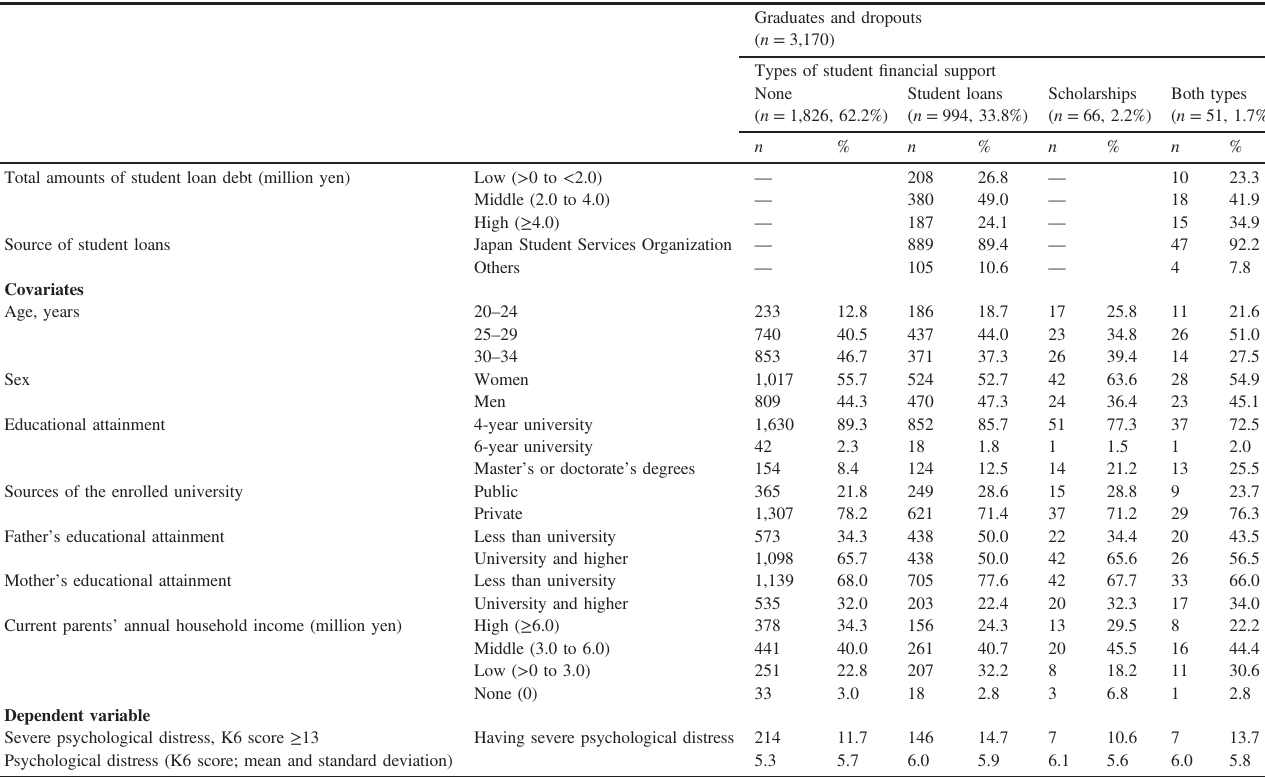
Table 1. Characteristics of graduates and dropouts according to the types of student fi nancial support